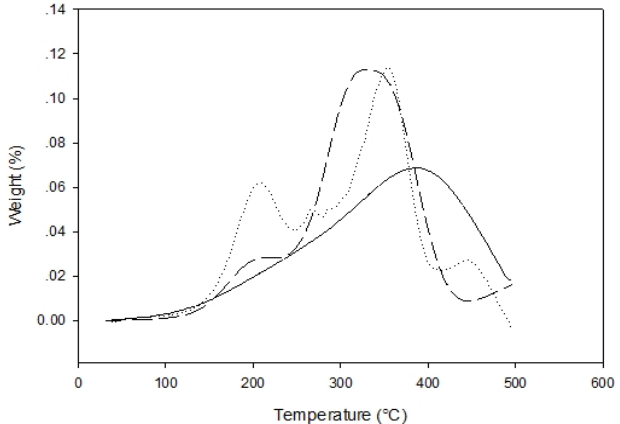
Figure 4. Percent weight against temperature on the effect of reaction temperature. ( 325 °C, Figure 8. Derivative of weight against temperature affecting reaction time ( Figure 2. Derivative weight as a function of temperature on the effect of catalyst loading. ( Figure 8. Derivative of weight against temperature affecting reaction time ( 350 °C , 400 °C). 0.5% catalyst, 90 min).